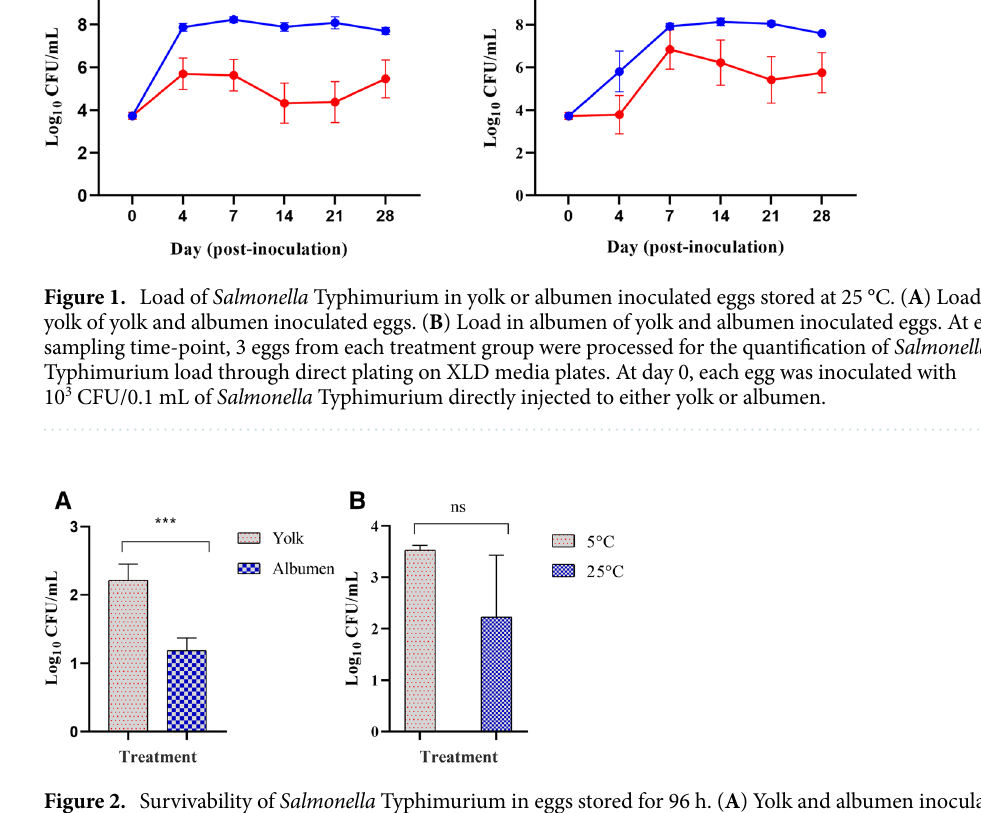
Figure 2. Survivability of Salmonella Typhimurium in eggs stored for 96 h. ( A ) Yolk and albumen inoculated eggs stored at 5 °C. ( B ) Eggshell inoculated eggs stored at 5 °C or 25 °C. Individual eggs in each of the yolk and albumen treatment groups received 1 × 10 3 CFU/0.1 mL, and the eggs were stored at 5 °C for 96 h. For the shell treatment groups, intact eggs were dipped in Salmonella inoculum containing 1 × 10 6 CFU/mL of LB broth and stored at 5 °C or 25 °C for 96 h. The stored eggs were processed for the recovery of Salmonella and the load was presented as log 10 CFU/ mL of albumen, yolk or shell rinsate. Within each storage temperature, different superscripts show significant differences (P < 0.05). Values are mean of log 10 CFU ±